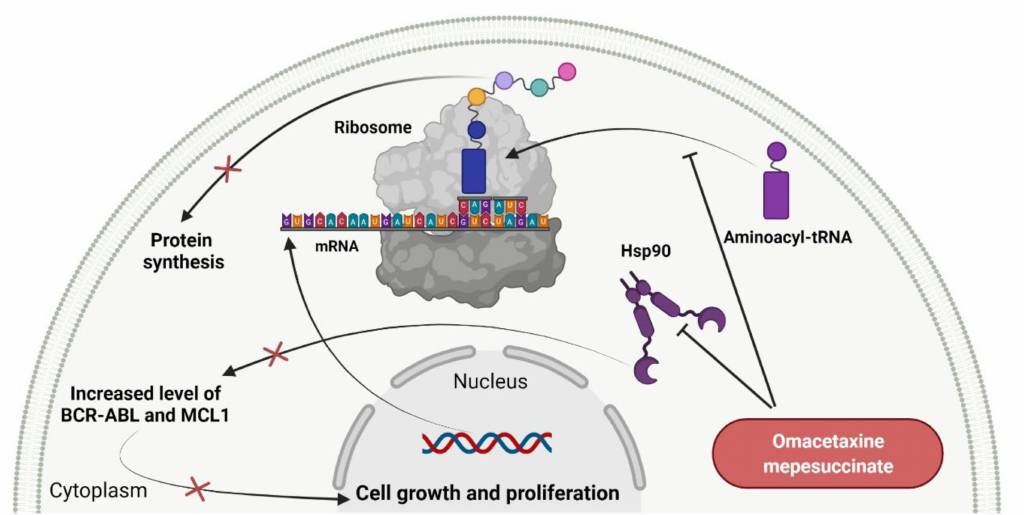
Figure 7. Schematic representation of major mechanisms of action for omacetaxine mepesuccinate. BCR-ABL : BCR-ABL fusion protein. MCL1 : myeloid cell leukemia 1. mRNA : messenger ribonucleic acid. tRNA : transfer ribonucleic acid. Hsp90 : heat shock protein 90. Created with